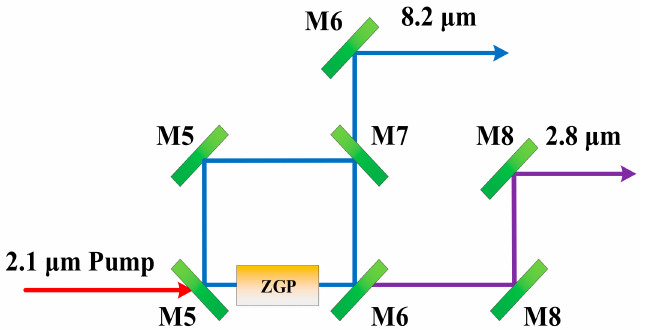
Figure 2. Experimental setup of ZGP OPO.